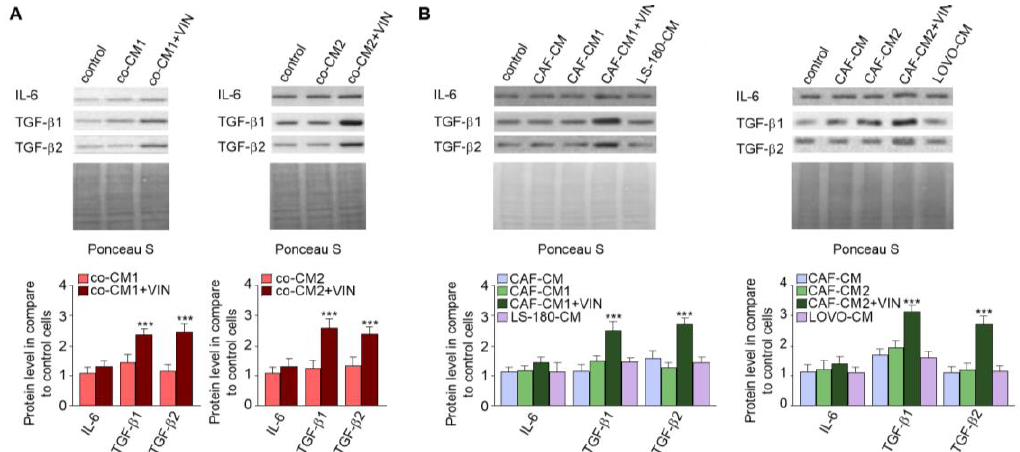
Figure 4. Vincristine enhances secretion of TGF- β s and IL-6 in CAF-like cells through its paracrine interaction with colon cancer cells. Level of TGF- β s (TGF- β 1 and TGF- β 2) and IL-6 in CM isolated from coculture of CAF-like cells and colon cancer ( A ) or CAF-like cells maintained in colon cancer cell CM (and treated, if necessary, with vincristine) were studied ( B ) by Western blot. The results are provided as means ± SD ( n = 3); *** p < 0.005. As the control of loading, the Ponceau Staining was shown. The blots are representative of three independent experiments.